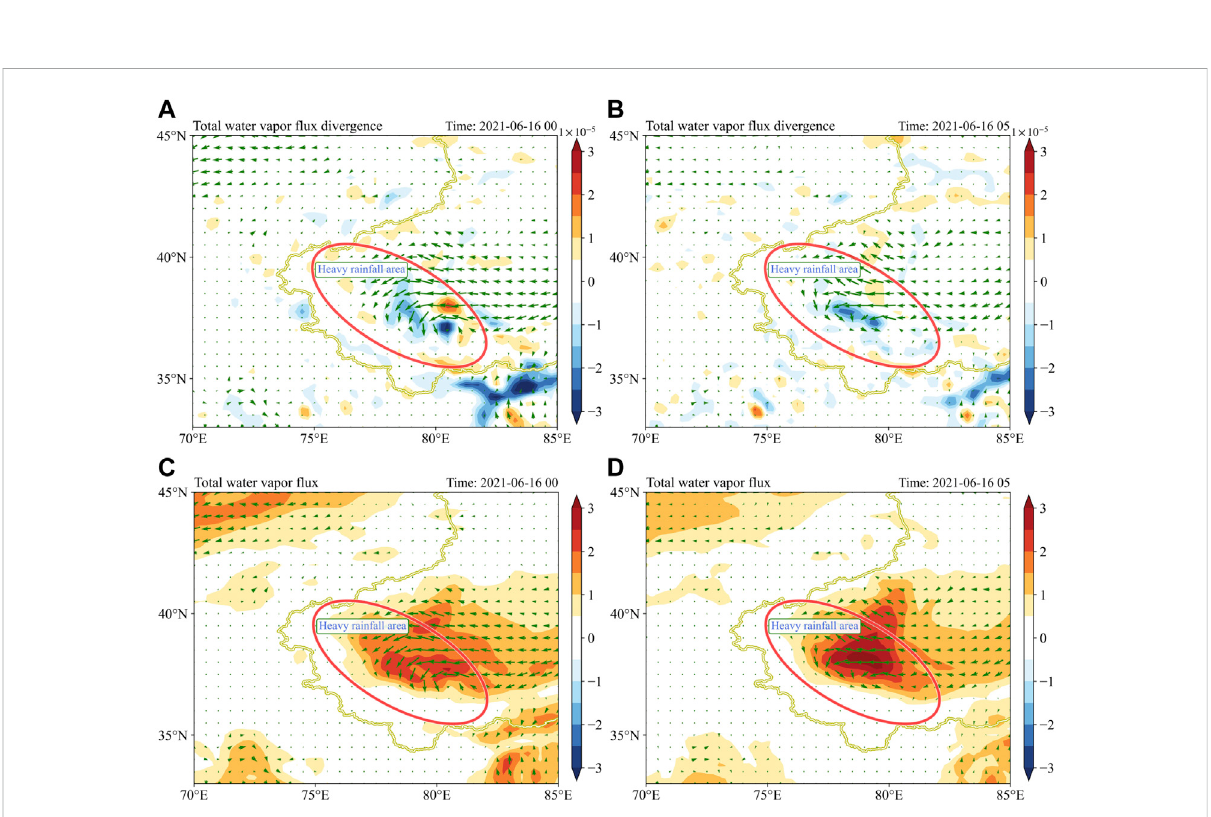
FIGURE 12 Total water vapor fl uxdivergenceat00:00 16June 2021 (A) and05:00 16 June2021 (B) (BJT)and Total water vapor fl uxat00:00 16June 2021 (C) and 05:00 16 June 2021 (D) (BJT).